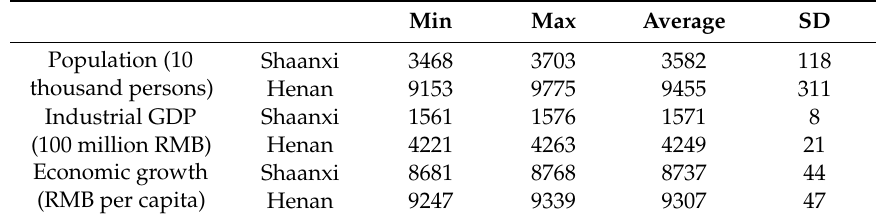
Table 2. Economic and demographic data in Henan and Shaanxi Provinces in 2050 among four scenarios.